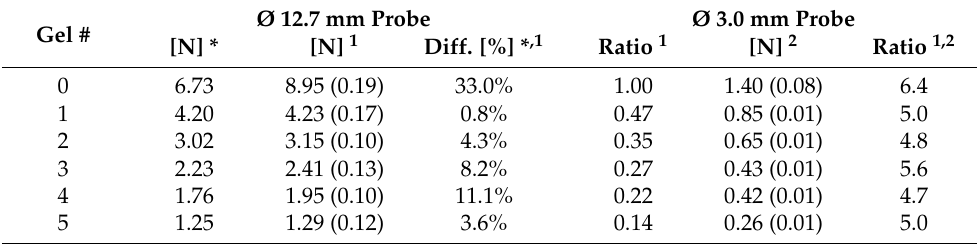
Table 3. Summary of firmness test